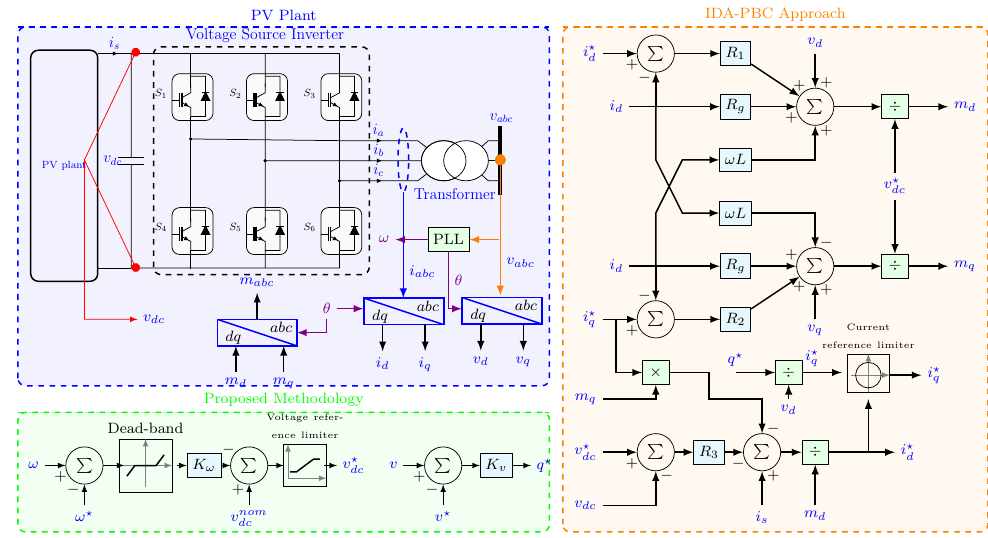
Figure 5. Proposed controller and methodological schemes.